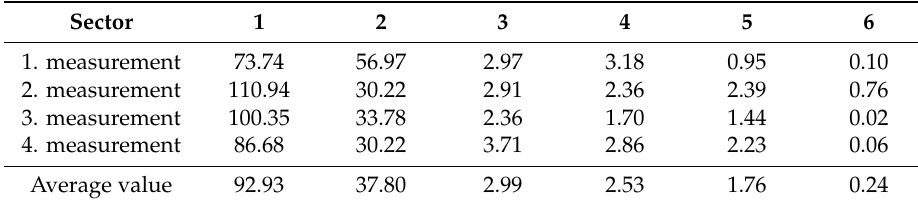
Table 1. The first set of measurements of oil film areal density (g/m 2 )—pipe with the inner diameter of 15 mm.